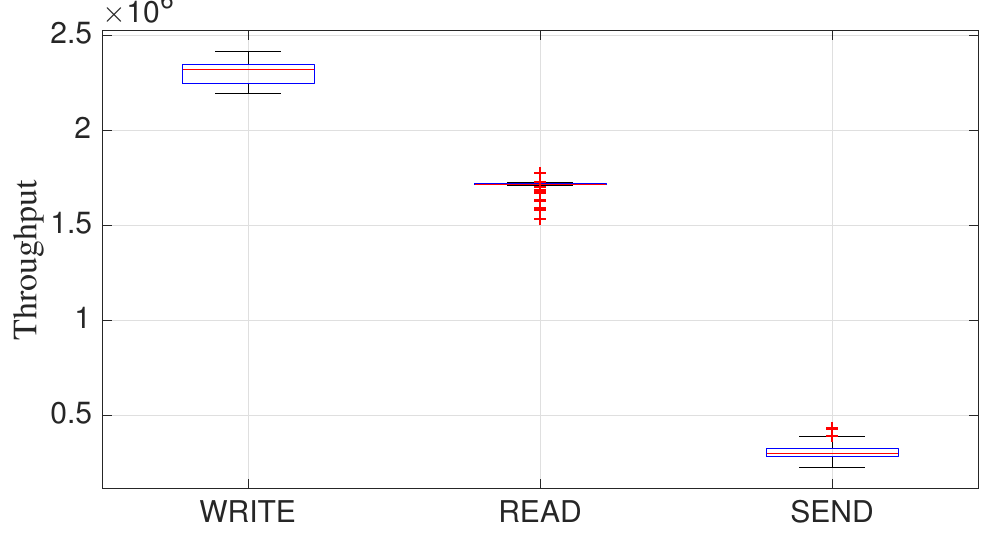
Figure 5. Variation on the RDMA